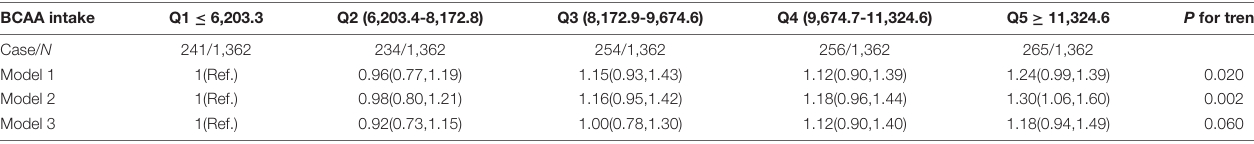
TABLE 5 | Association between Mean dietary branched-chain amino acids (BCAA) intake during follow-ups and hyperuricemia (HU) by Logistic regression model ( N =